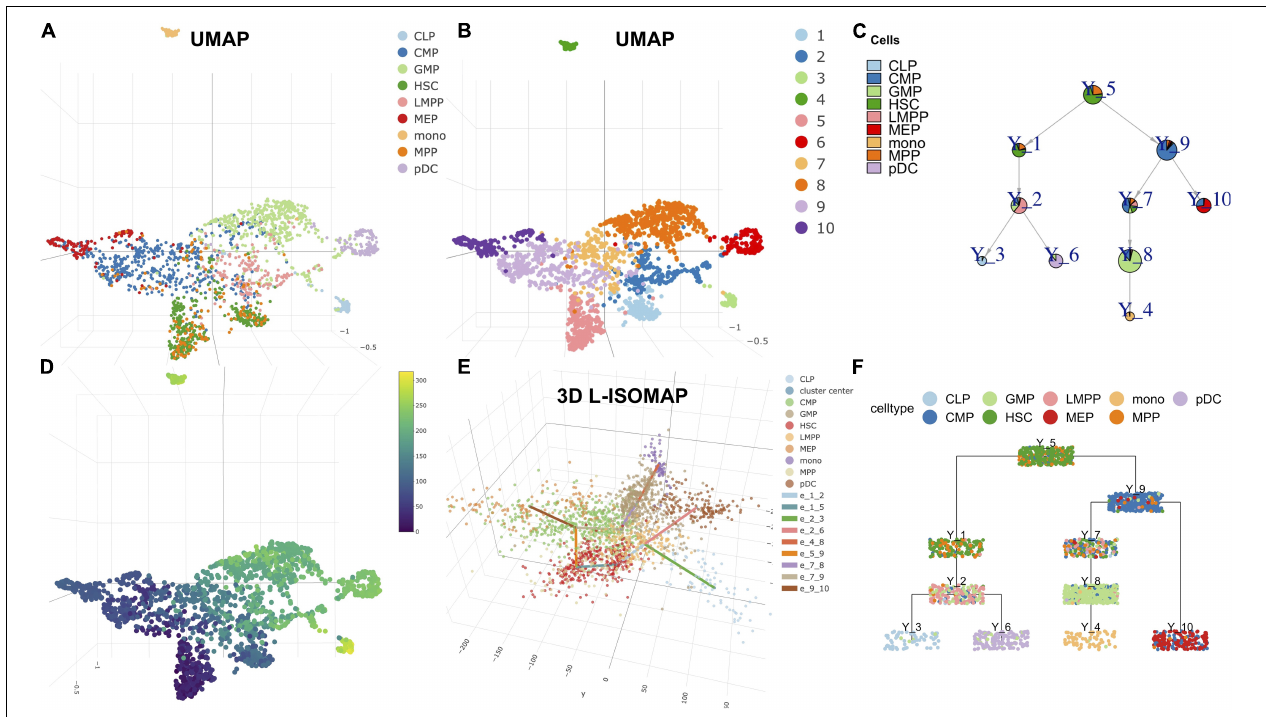
FIGURE 3 | LISA2 analysis of the development of hematopoietic stem cells (HSC) using single-cell sequencing assay for transposase-accessible chromatin (scATAC-seq) data. (A) The cell type visualization in UMAP. (B) The clustering results on UMAP. (C) Pie tree plot shows the cell types and trajectory. (D) The pseudotime plot in UMAP. (E) The 3D-ISOMAP and trajectory visualization. (F) Cell cluster tree plot shows the differentiation trajectory of HSC. All cell types include lymphoid multipotent progenitors (LMPPs), granulocyte monocyte progenitors (GMPs), plasmacytoid dendritic cells (pDCs), lymphoid progenitor cells (CLPs), common myeloid progenitors (CMPs), megakaryocytic cells (MEP), multipotent progenitors (MPPs), and monocytic cells